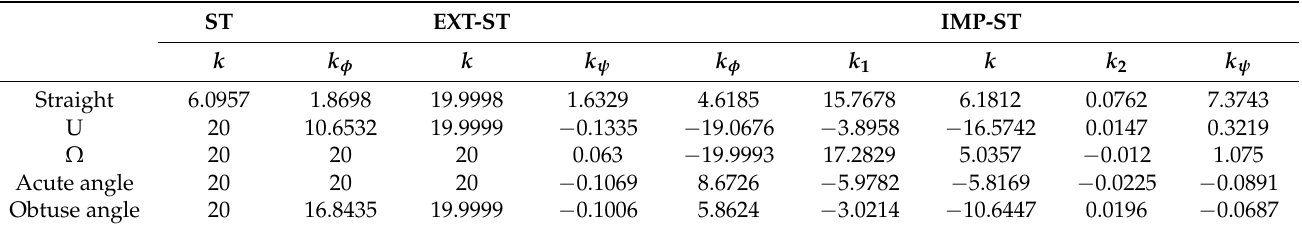
Table 2. The well-tuned parameters.